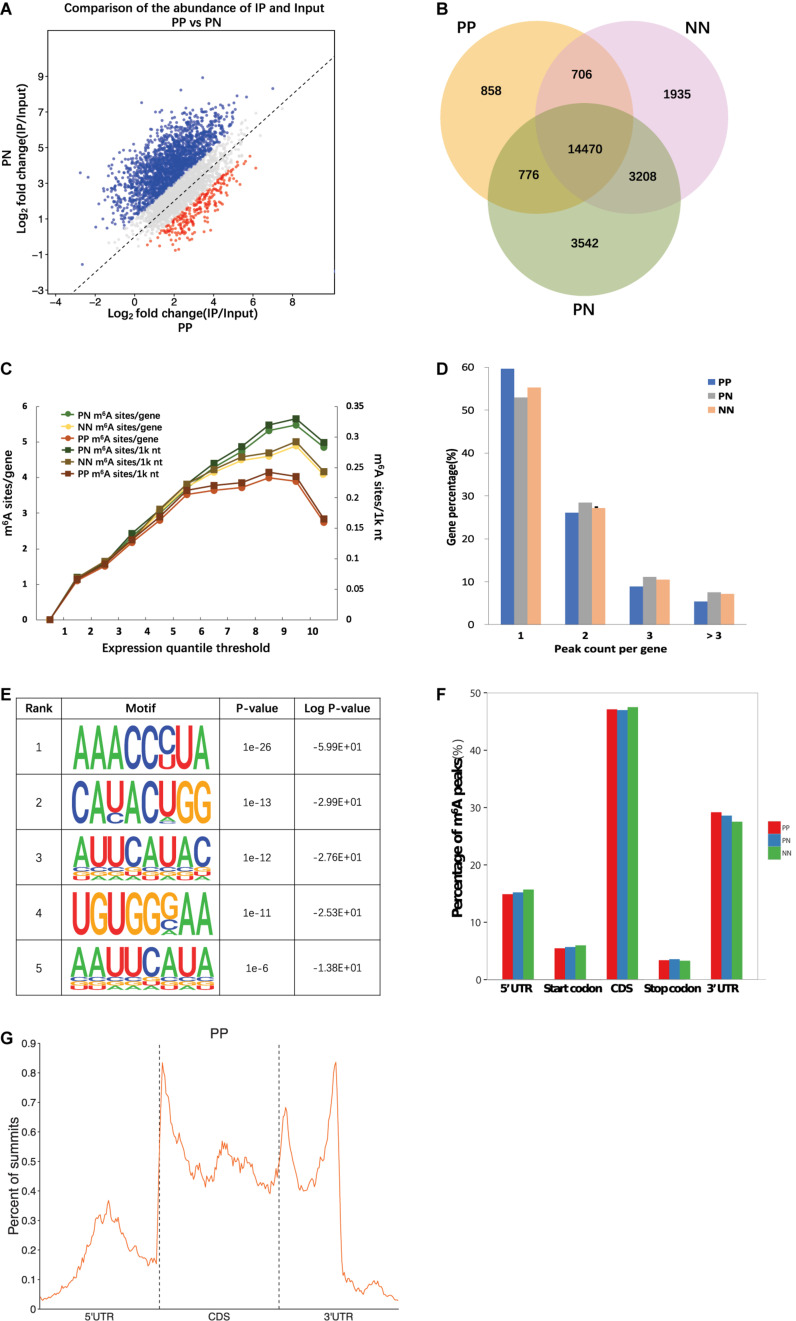
Overview of m6A methylome in psoriatic vulgaris skin. (A) Comparison of the number of m6A peaks identified in PP and PN. (B) Numbers of group-specific and common m6A peaks. (C) Estimation of m6A density on transcripts. Transcripts with different expression level are divided to 10 groups, and the m6A density of PP, PN, and NN samples is calculated separately. (D) Percentage of m6A methylated genes with different m6A peak number. (E) The top five motifs enriched across m6A peaks identified from involved psoriatic skin samples. (F) Distribution of m6A peaks across the length of mRNAs. 5′UTRs, CDS, and 3′UTRs of PP mRNAs are individually binned into regions spanning 1% of their total length, and the percentage of m6A peaks that fall within each bin is determined. (G) The distribution of m6A peak from PP along a metagene.